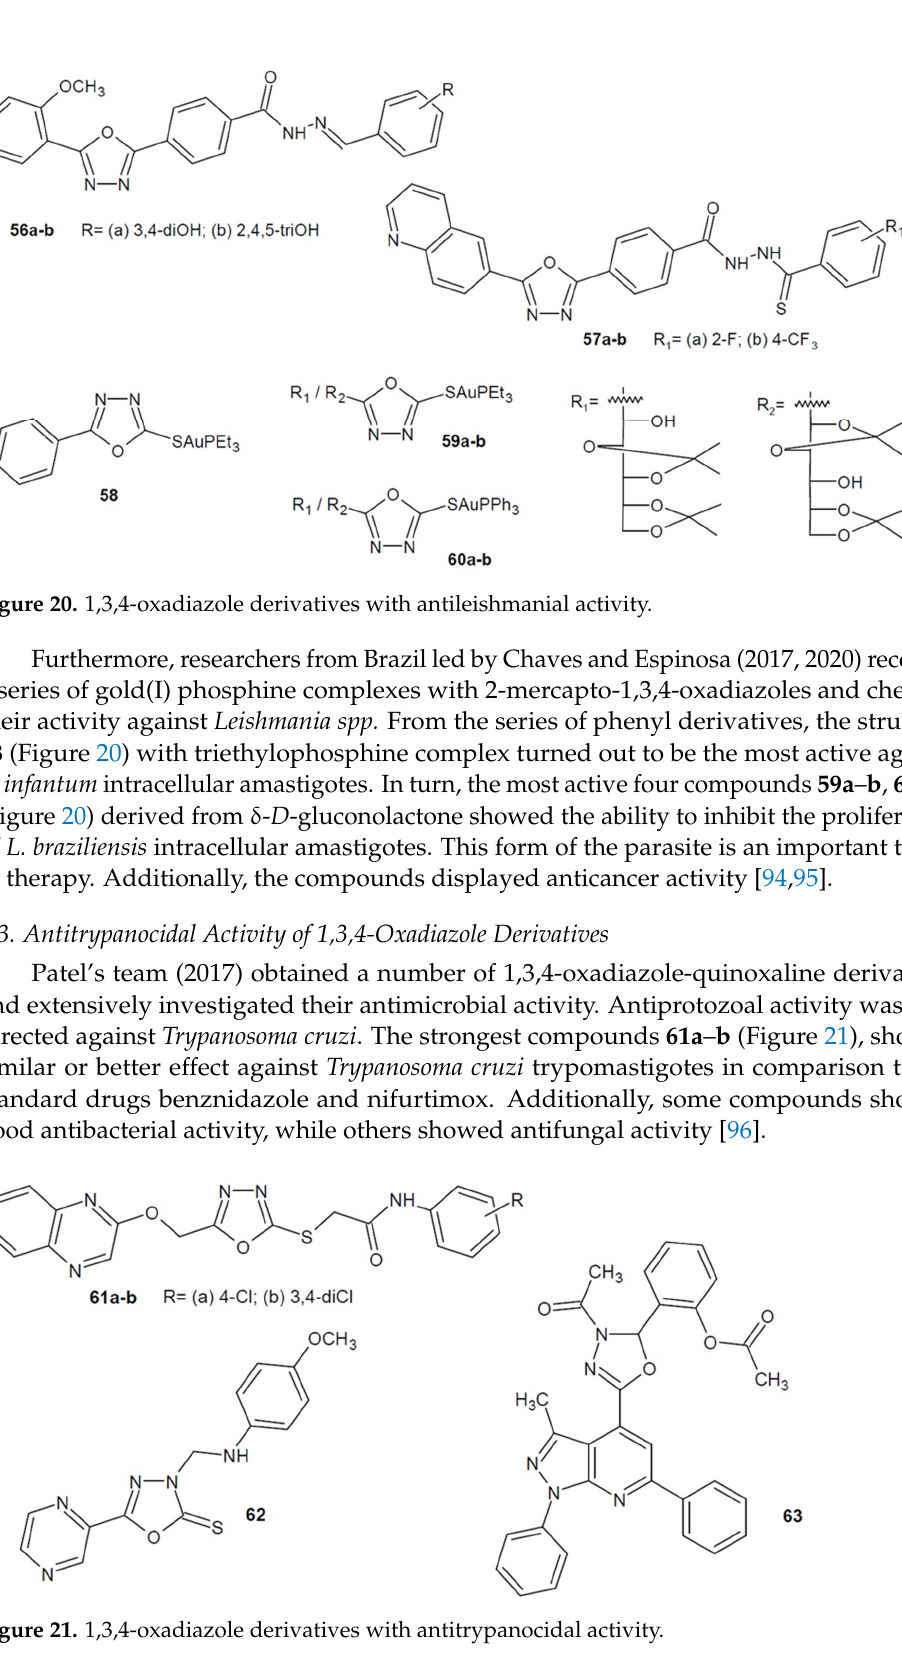
Figure 21. 1,3,4-oxadiazole derivatives with antitrypanocidal